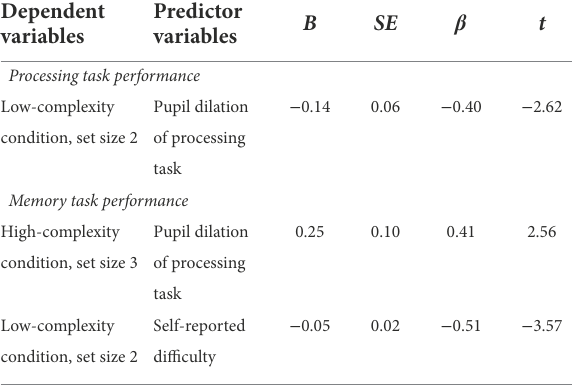
TABLE 5 Results of the stepwise regression analysis of CL